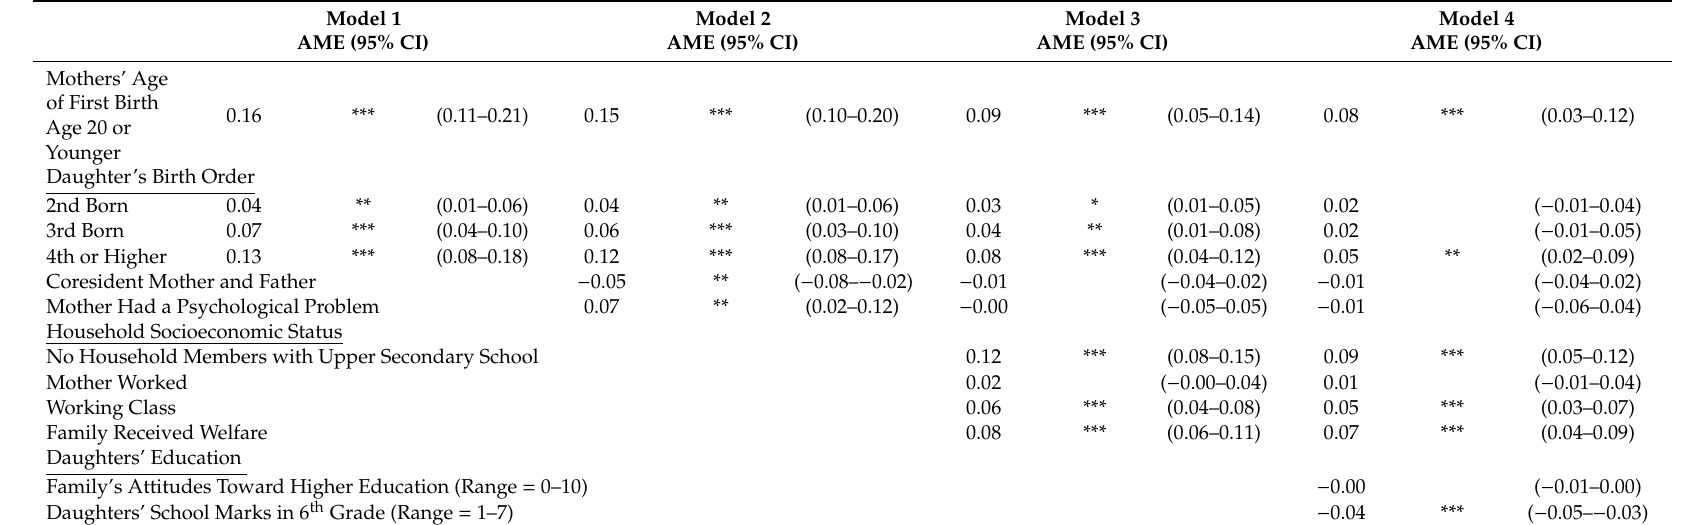
Table 2. Results from Logistic Models: Average Marginal E ff ects (AME) of Daughters’ Early Childbearing by Mothers’ Early Childbearing ( N = 4834) 1